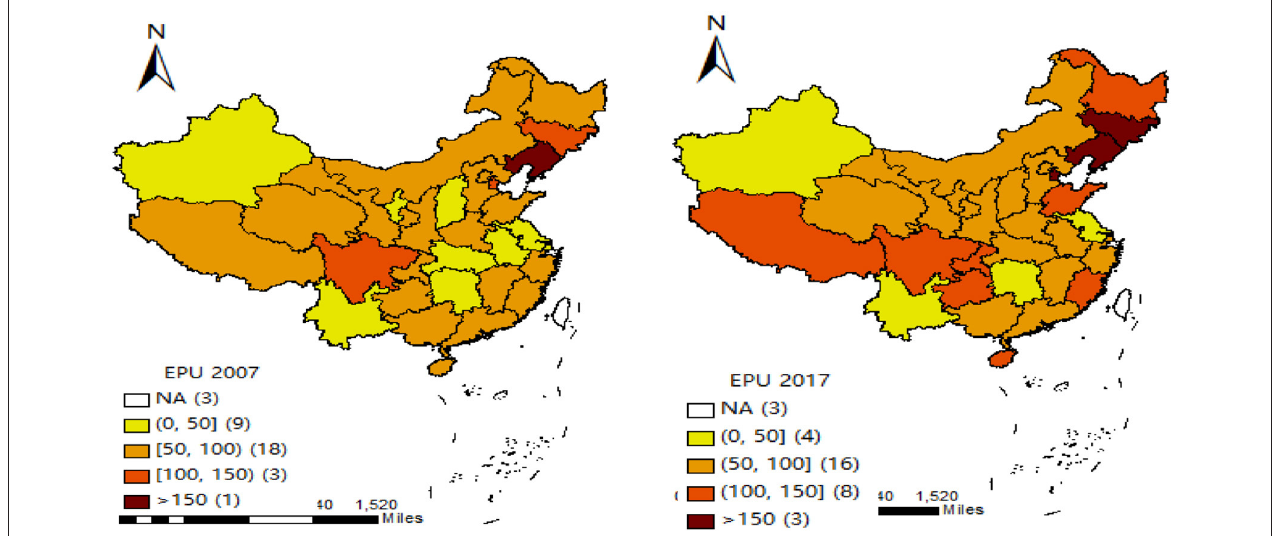
FIGURE 2 | Distribution of the provincial EPU index in China (2007 and